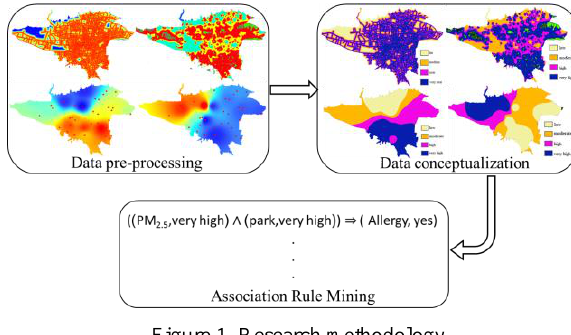
Figure 1. Research methodology